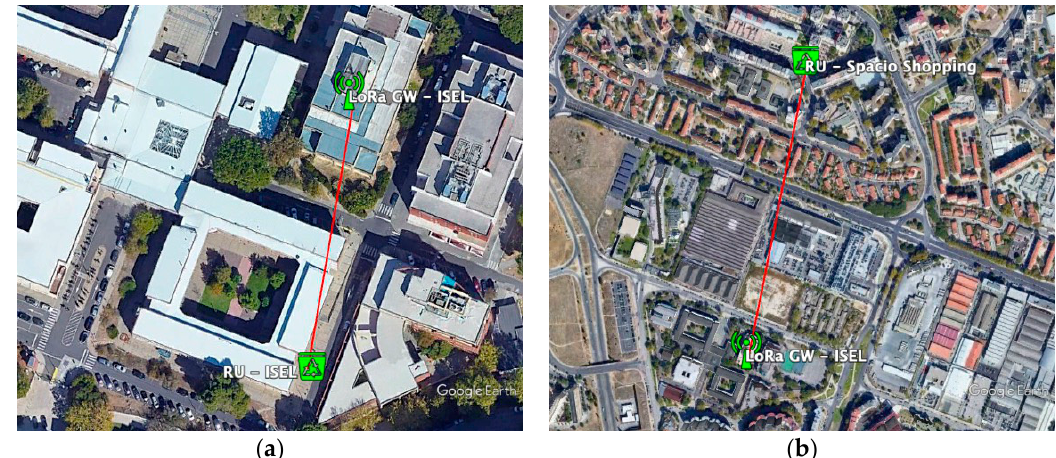
Figure 9. Map showing the distances from the LoRa GW at ISEL to sensors at ( a ) the underground containers (RU); ( b ) at ISEL.